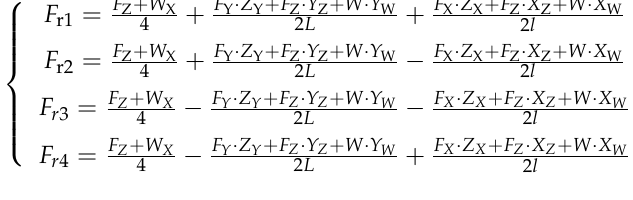
D E Figure 6. Schematic diagram of statically indeterminate workbench.